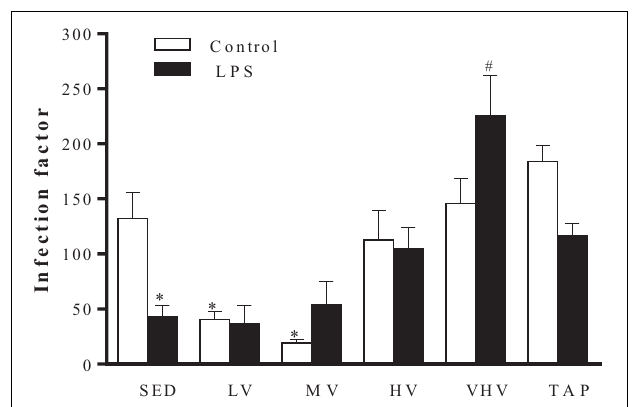
FIGURE 2 | Effect of chronic physical exercise on the interaction between BALB/c mice peritoneal macrophages and Leishmania major promastigotes. Values represent the mean and standard error of at least five animals per group. ∗ P < 0.001 in relation to the sedentary group without LPS and # P < 0.05 in relation to the sedentary group with LPS. Groups: sedentary control (SED), low volume (LV), medium volume (MV), high volume (HV), very high volume (VHV), and tapering